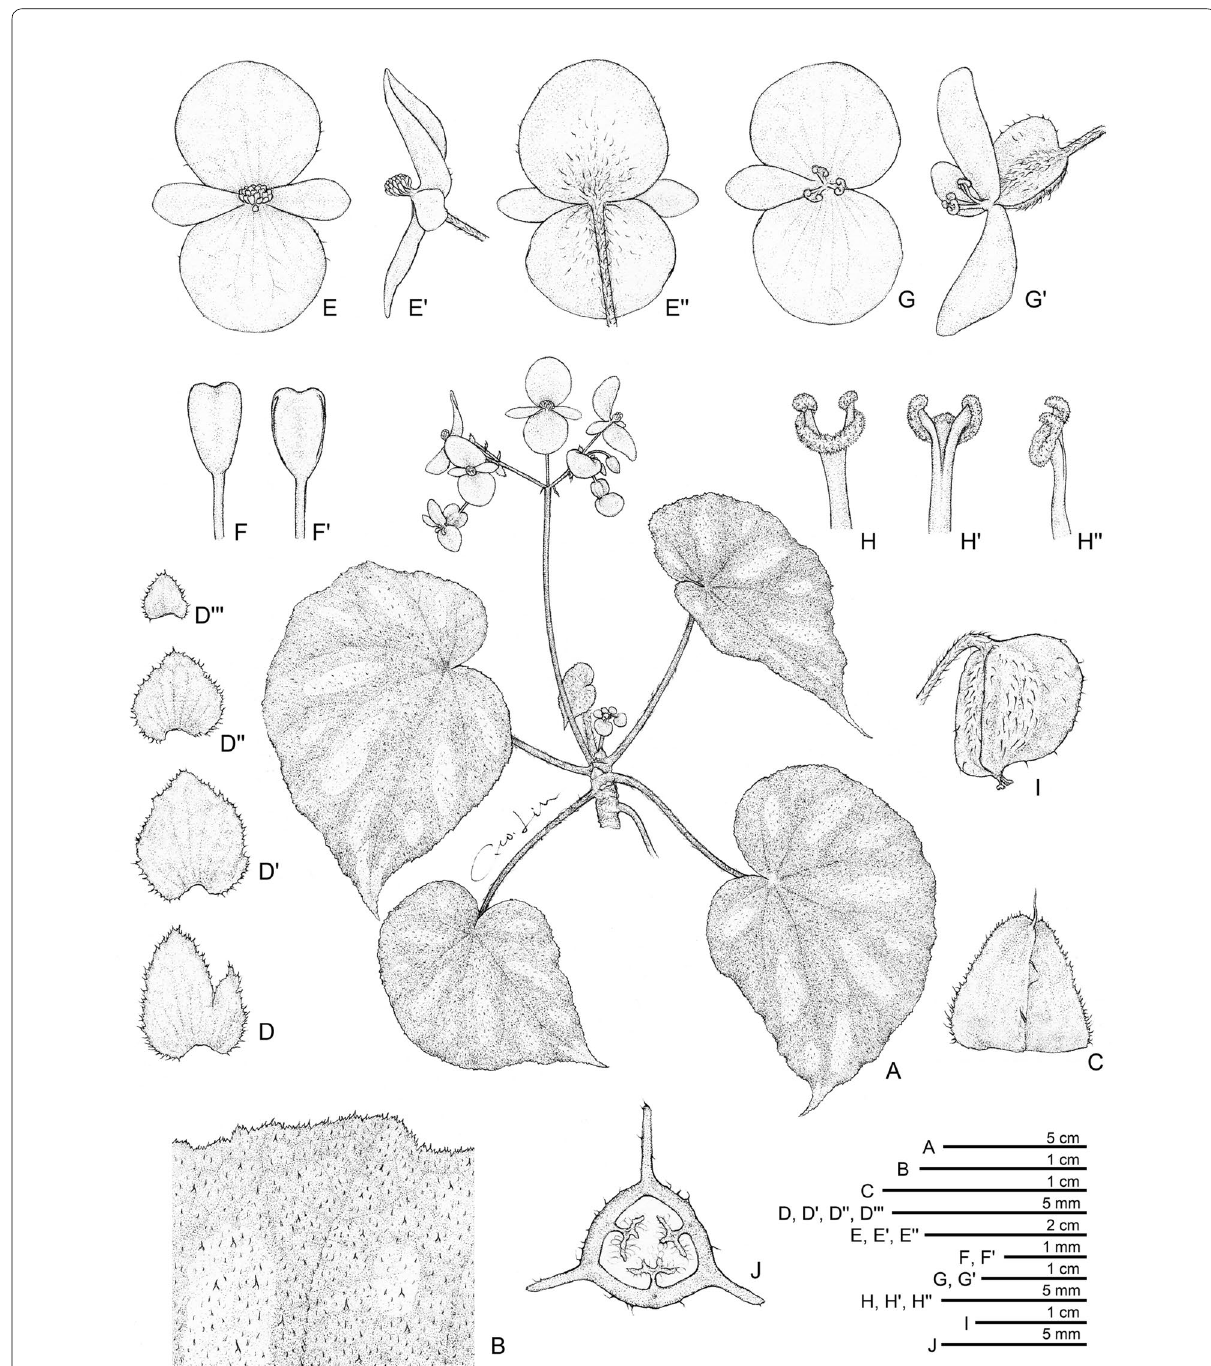
Fig. 12 Begonia scabrifolia C.I Peng, Yan Liu & C.W.Lin. A Habit; B Portion of adaxially leaf; C Stipule; D , D’ , D’’ , D’’’ Bracts, lower to upper; E , E’ , E’’ Staminate flower, face, side and back views; F , F’ Stamen, dorsal and ventral views; G , G’ Pistillate flower, face and side views; H , H’ H’’ Style and stigmatic band, dorsal, ventral and side views; I Capsule; j Cross section of an immature capsule. All from Peng